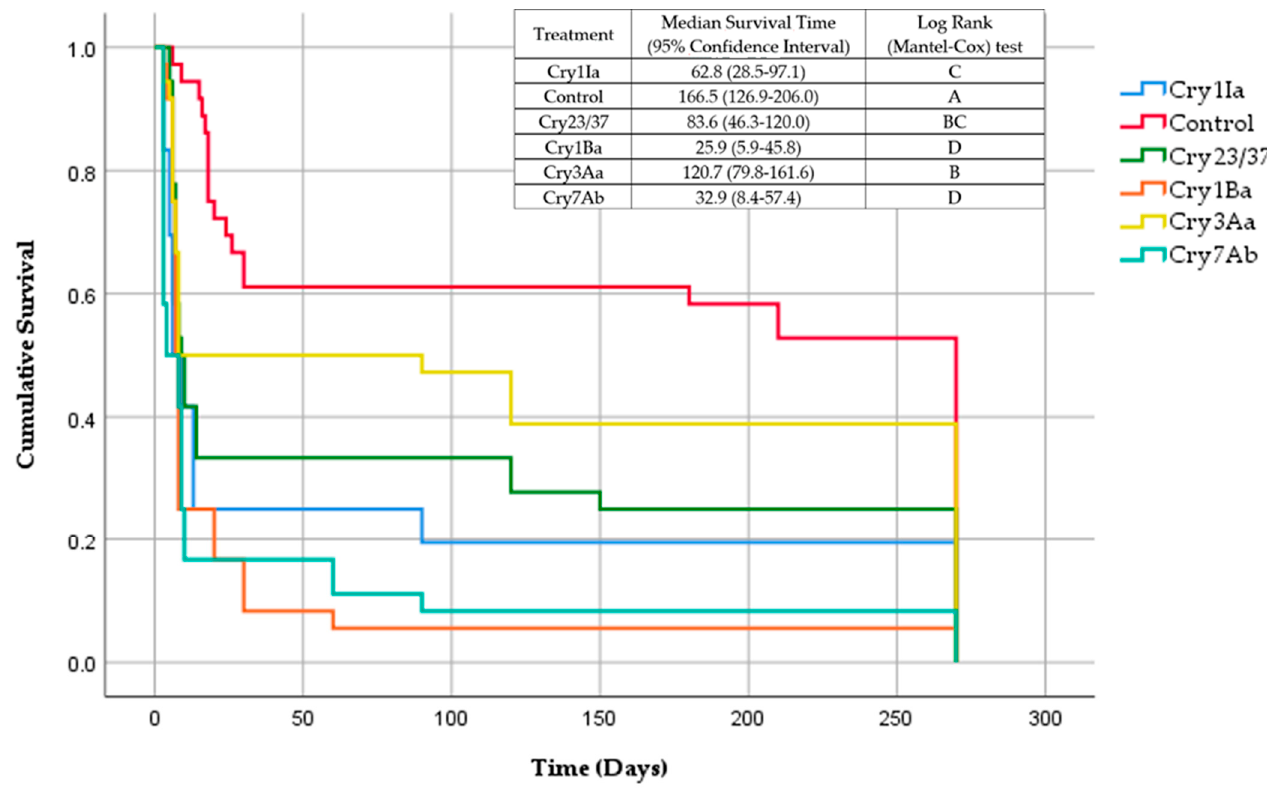
Figure 1. Kaplan–Meier cumulative survival curves for Xylotrechus arvicola larvae exposed to 1 µg/cm 2 of Cry proteins applied to an artificial diet.